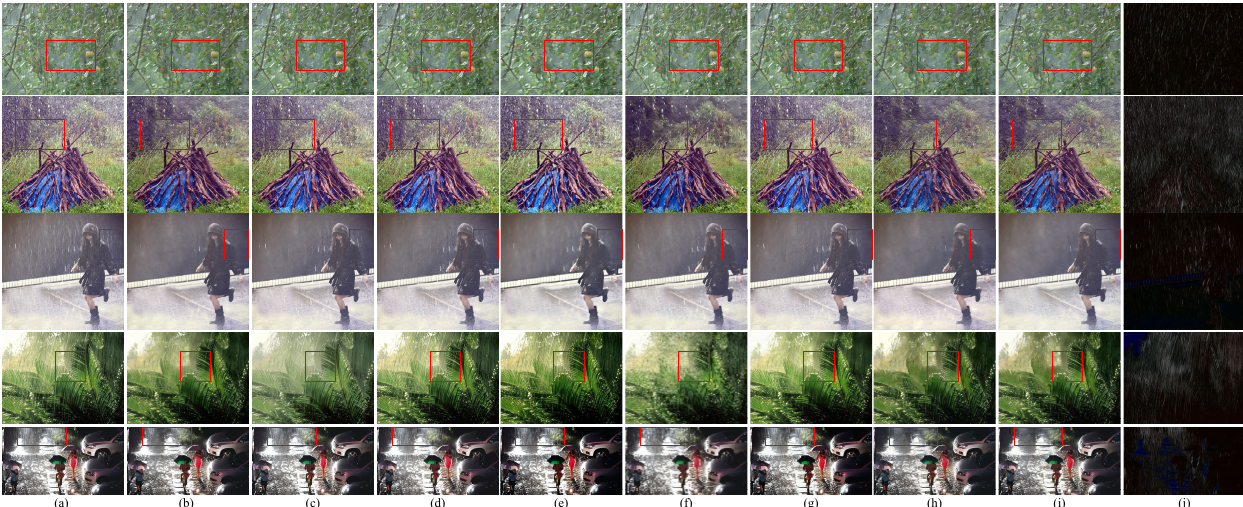
Figure 9. The visualization results by comparing SOTA methods from the real-world dataset Real300 . ( a ) Rain image. ( b – g ) Results from RESCAN [12], MPRNet [16], PCNet [17], ReMAEN [32], MSPFN [13], DID-MDN [40]. ( h ) Deraining result from CR stage of our method. ( i ) Deraining result from RR stage of our method. ( j ) Rain streak by our method. Please zoom in to see clearly. Two Downstream Tasks. We use YOLOv5, an optimized version based on YOLOv4 [5], to verify the image quality restored by different deraining methods in the object detection tasks. The model parameter is provided from